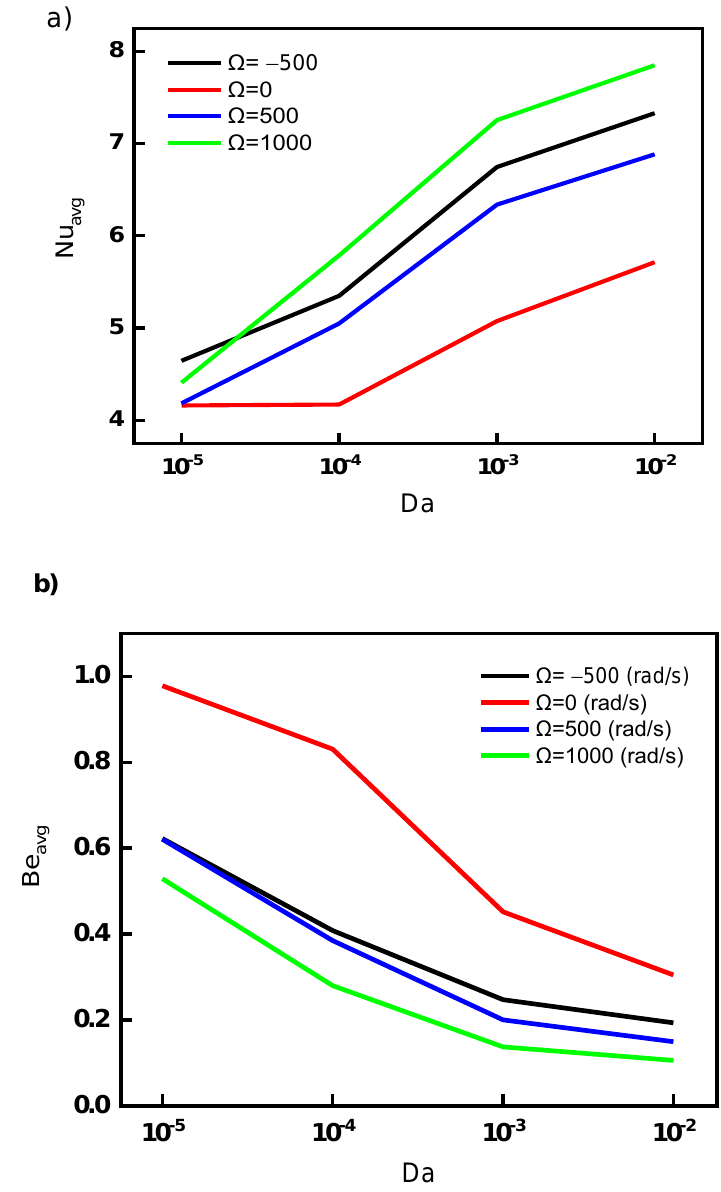
Figure 7. Impact of Darcy number on ( a )Nu avg and ( b )Be avg for various cylinder rotating